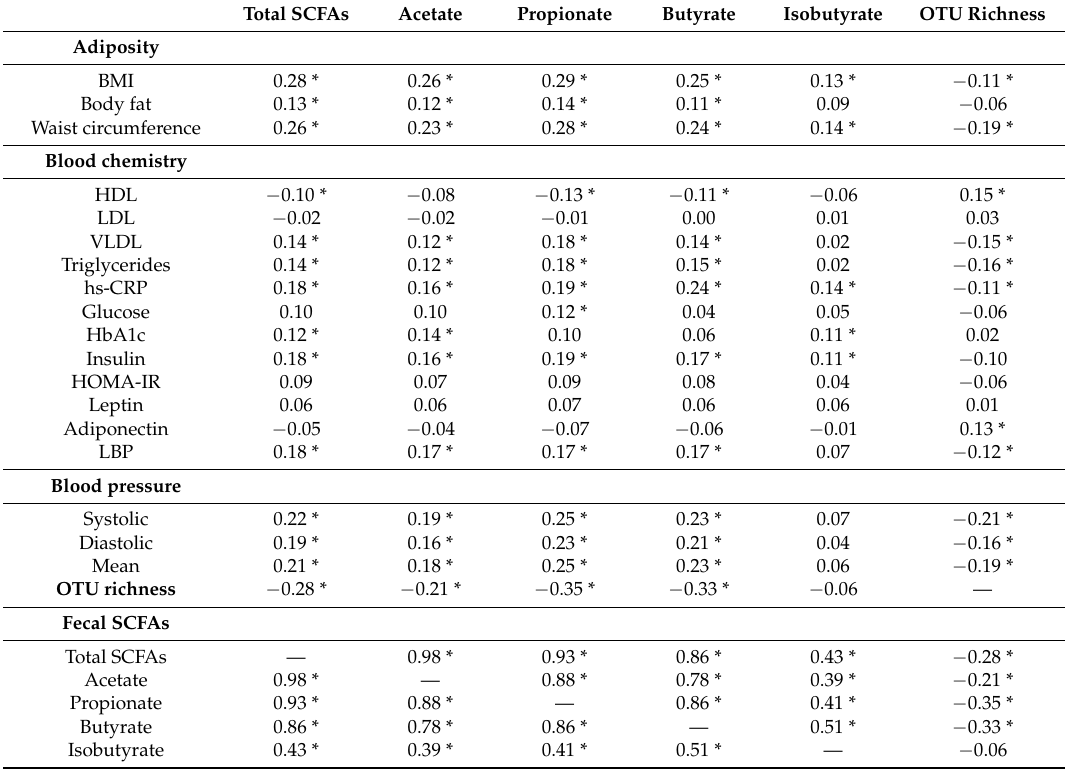
Variables adjusted for age, city of origin, caloric intake, physical activity, and fiber intake. FDR-adjusted p -values are highlighted (* q < 0.05).